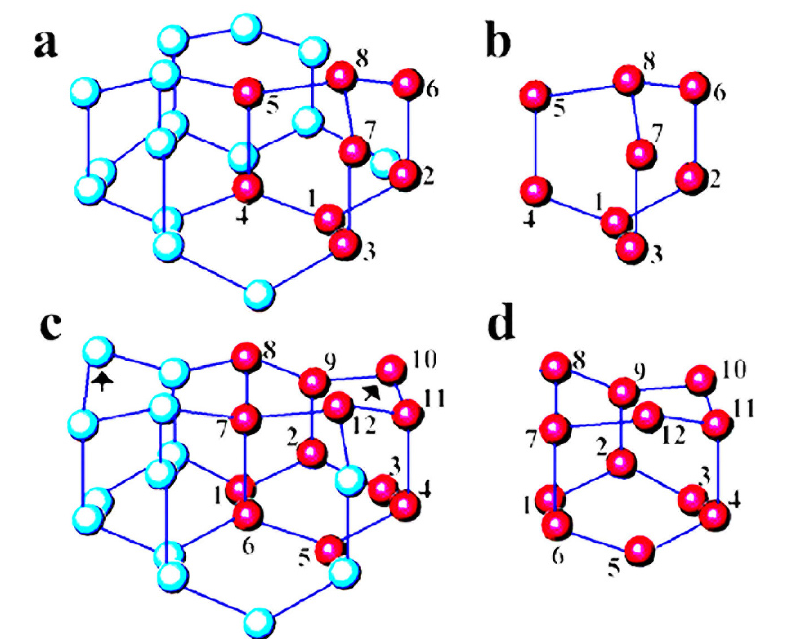
Figure 2. Turning C8 to C12 unit. a) Three C8 structures surround the central C shown separately. c) Addition of carbon atoms indicated by the arrows is turning C8 to C12. d) One C12 unit is numbered and shown